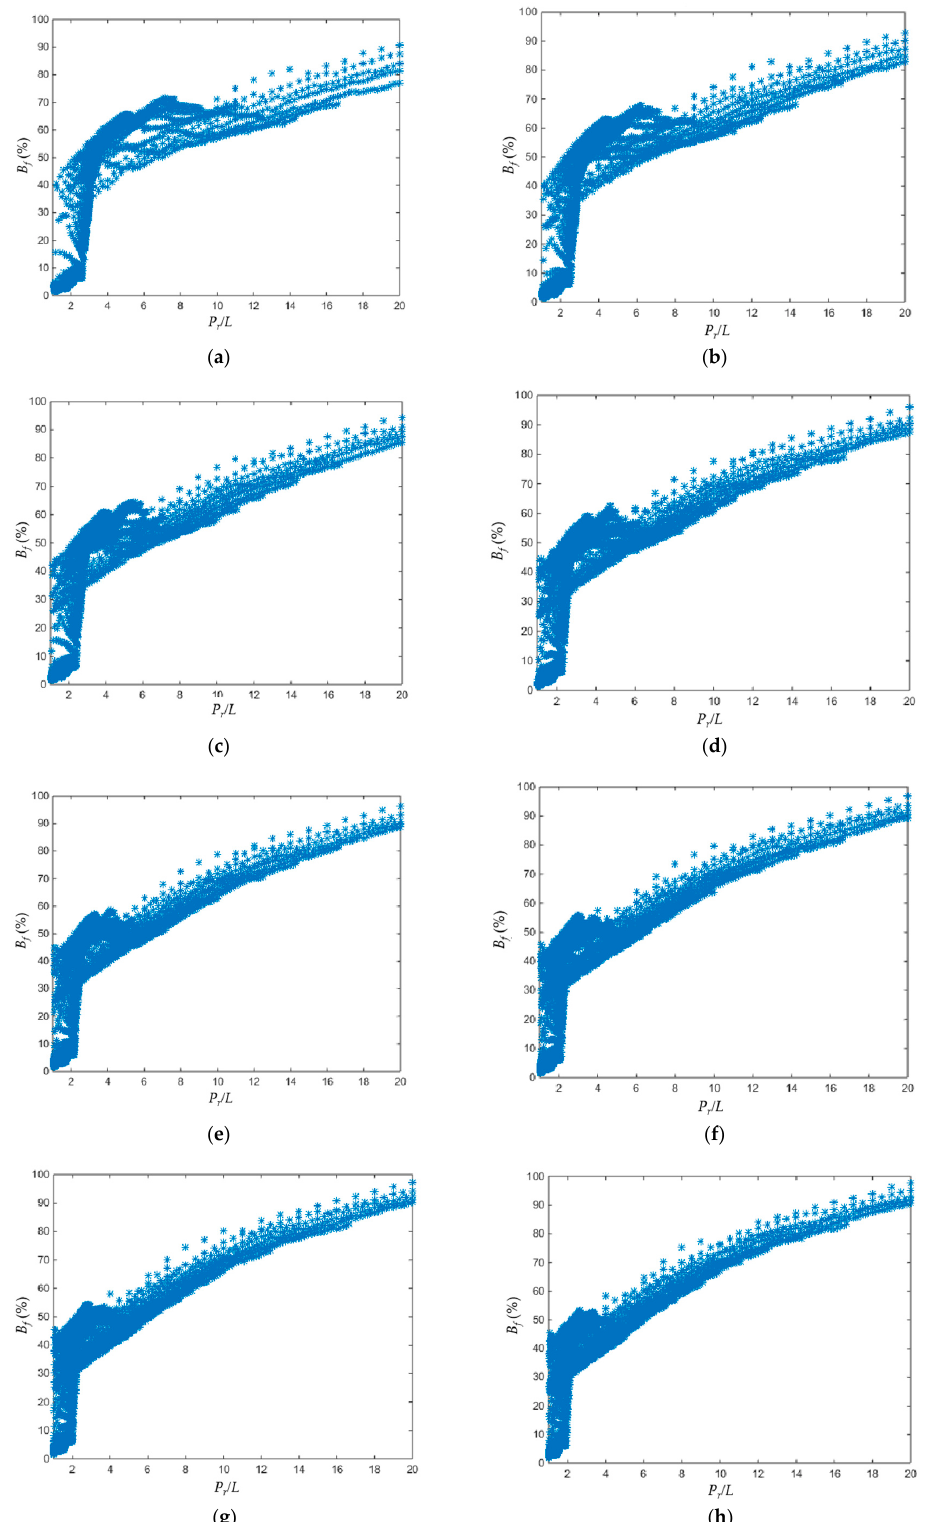
Figure 4. Scatter Diagram of the battery level coefficient ( B f ) with the variation of the PV array installed capacity ( P m ): ( a ) P m = 20 kW; ( b ) P m = 30 kW; ( c ) P m = 40 kW; ( d ) P m = 50 kW; ( e ) P m = 60 kW; ( f ) P m = 70 kW; ( g ) P m = 80 kW; ( h ) P m = 90 kW.